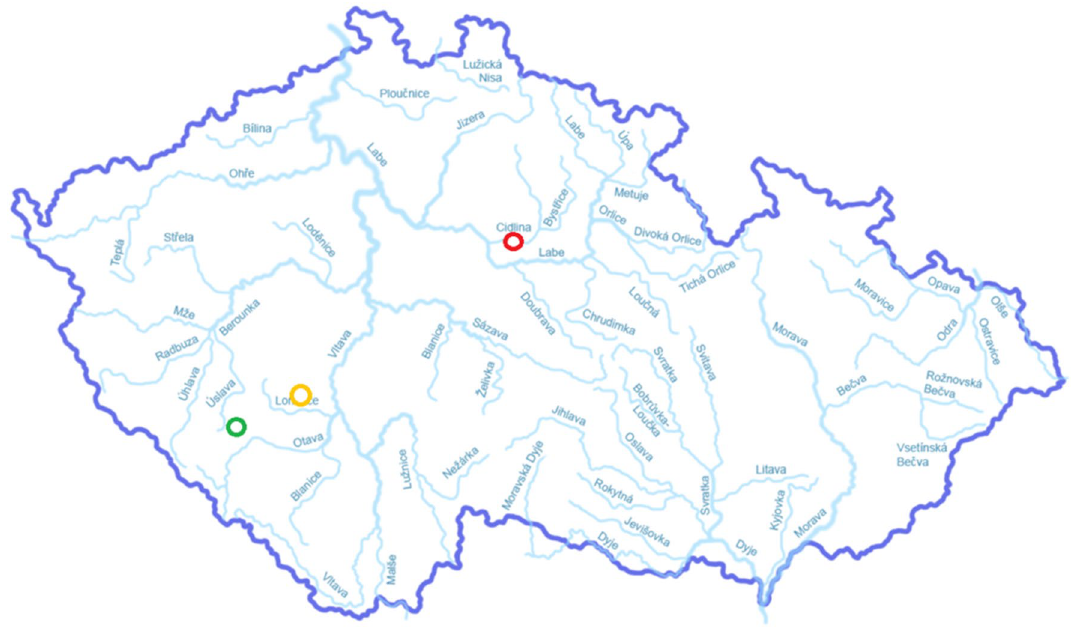
Figure 1. Location of the sampling sites: red—Zehunsky pond, yellow—Mysliv pond, green—Velky Kocelovicky